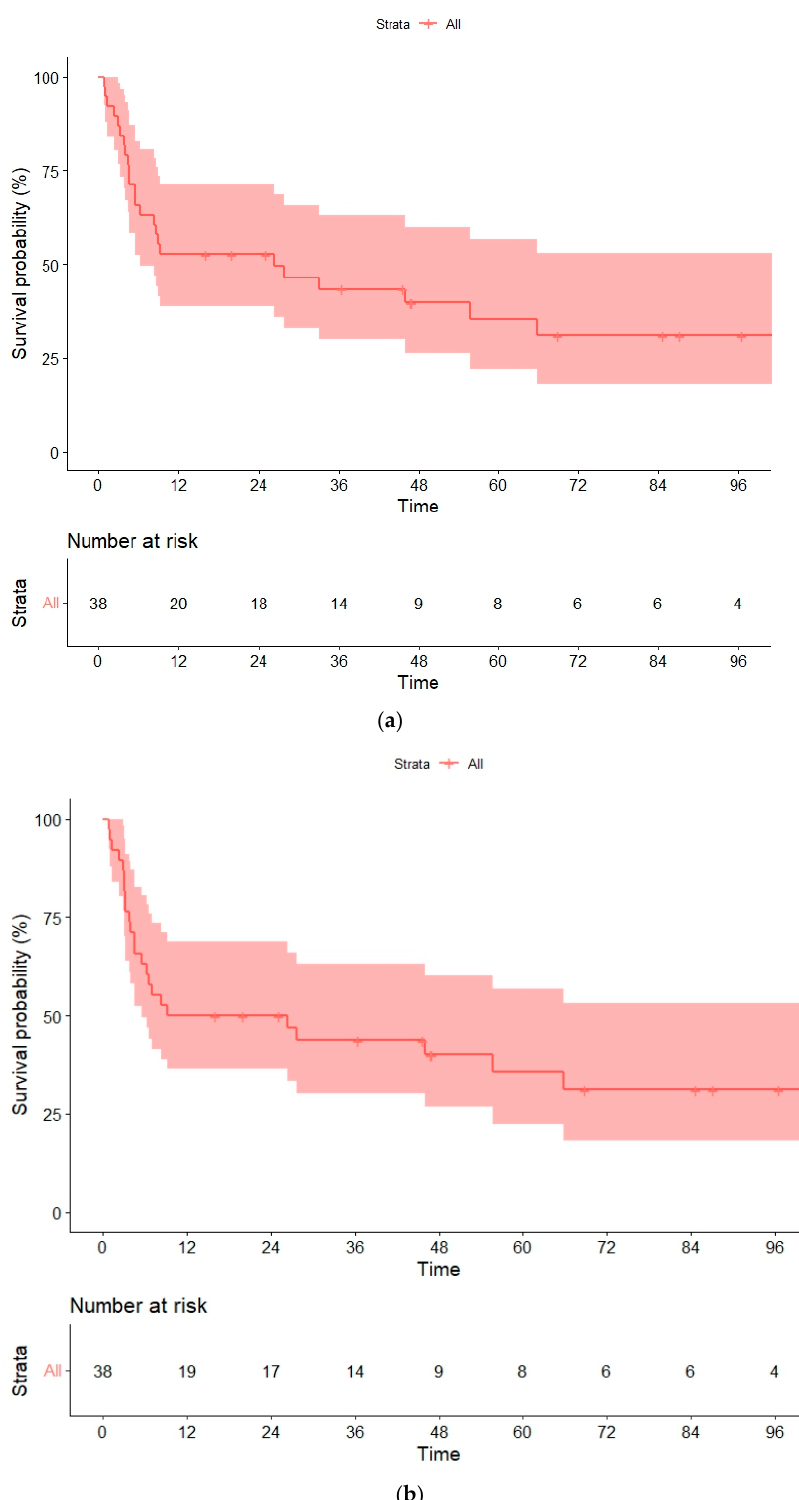
Figure 1. ( a ) Overall survival (OS) and ( b ) progression-free survival (PFS) in the global series. In the univariate analyses, the conditioning regimen and development of cGVHD were the only factors significantly associated with OS (Table 3). Three-year OS estimates were 52% and 20%, respectively, for patients treated with the RIC and MAC regimen ( p =